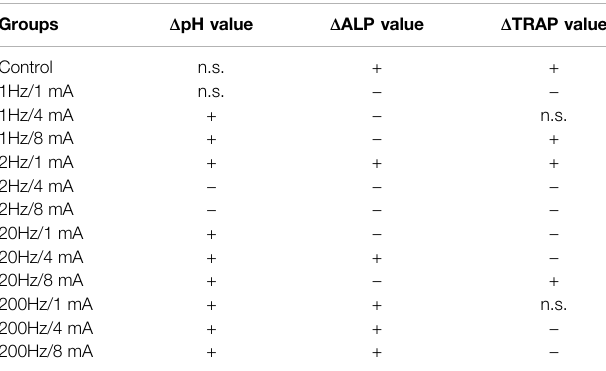
TABLE 1 | The positive and negative expression of the in vitro OB/OC co-culture system after ES. n.s.: no statistically signi fi cant difference.